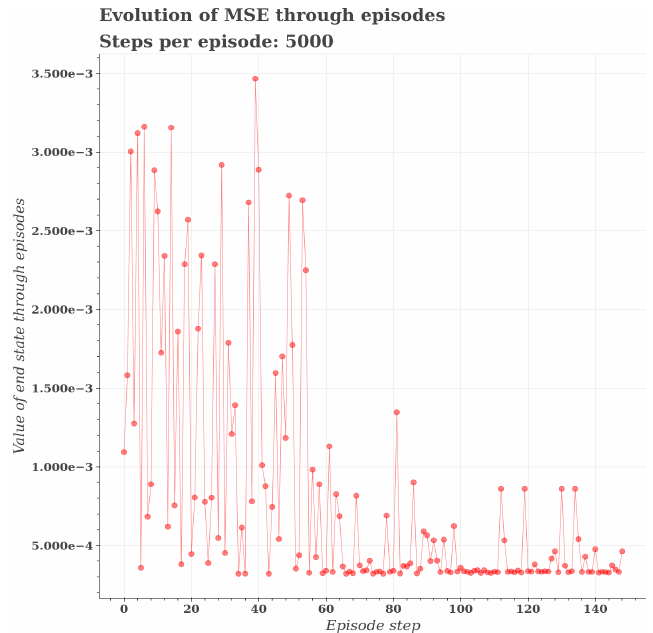
Figure 12. MSE between original data and estimated solution at the end of each of the 150 episodes for the conjunctive function. After the exploration phase, the MSE converges to